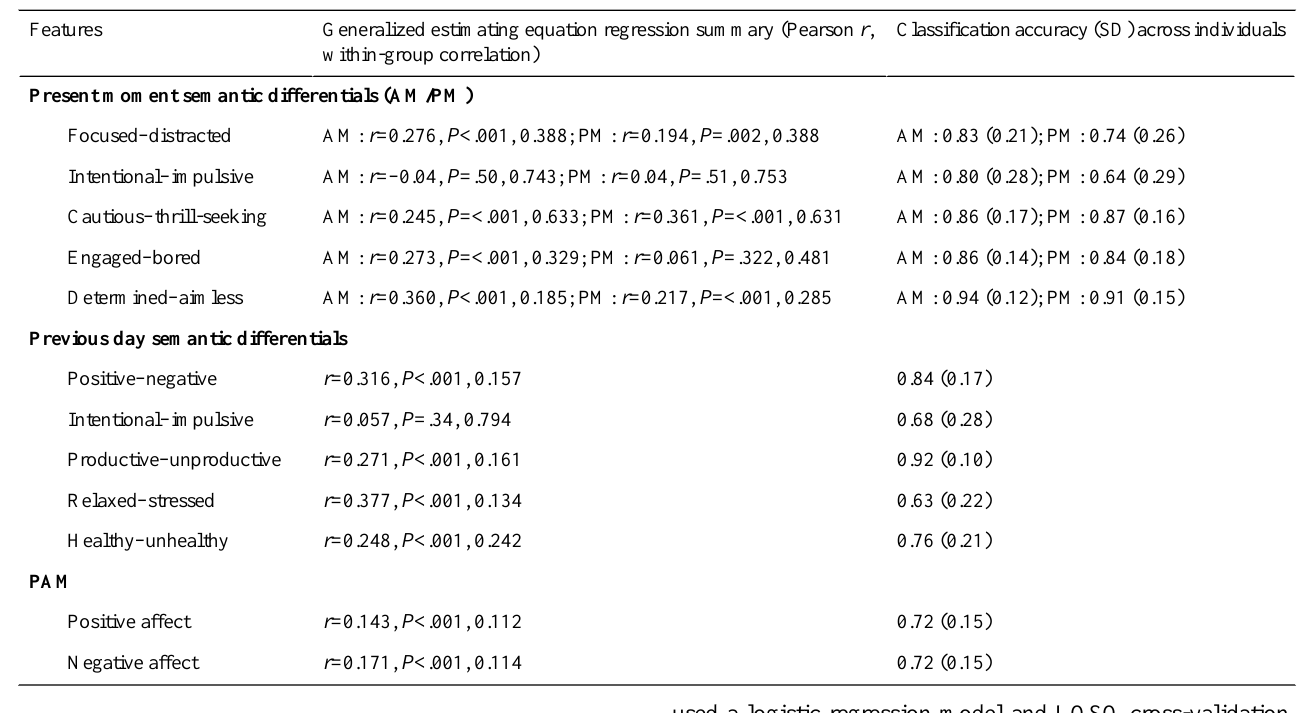
Table 4. Regression analysis and classification of mobile sensor data as predictors of daily ecological momentary assessment questions for semantics differentials and the Photographic Affect Meter (PAM).